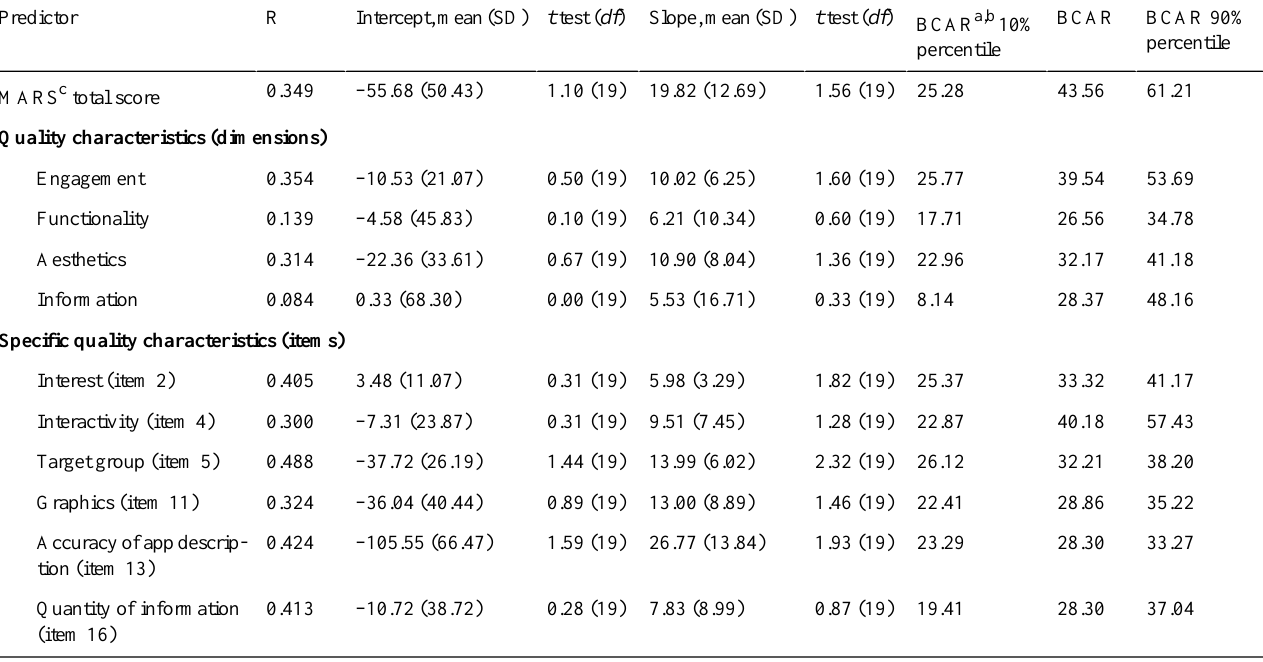
Table 2. Regression analysis app characteristics correlated with moderate-effect sizes for adoption of COVID-19 tracing apps (results for Bayesian regression are based on 20,000 draws).